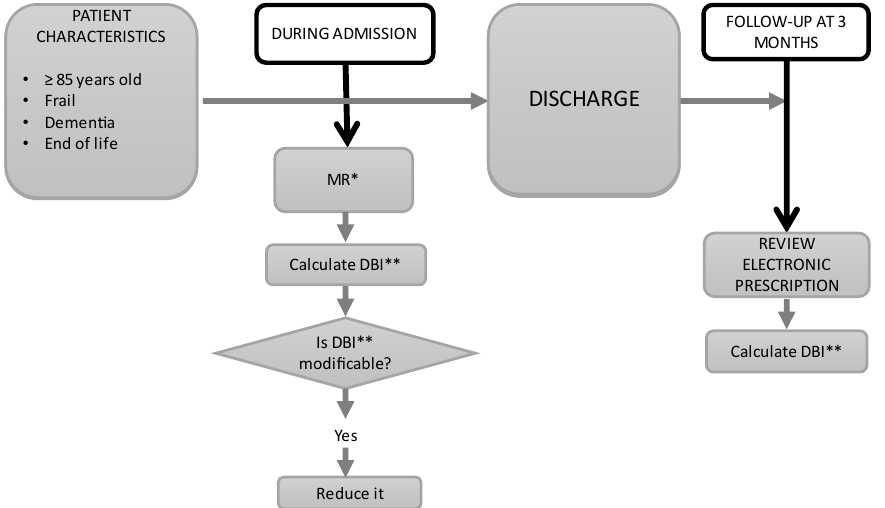
Figure 1. Overview of the interventions and assessment. * MR: medication review; ** DBI: drug burden index.